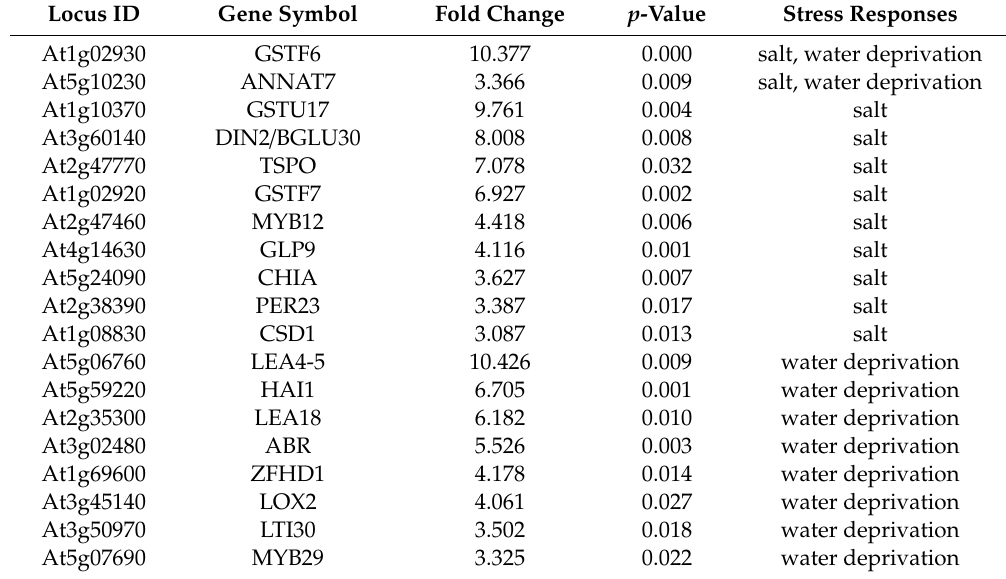
Table 4. List of 19 genes upregulated in AtRH17 OXs, enriched in “response to salt” (GO:000965) and “response to water deprivation” (GO:0009414).